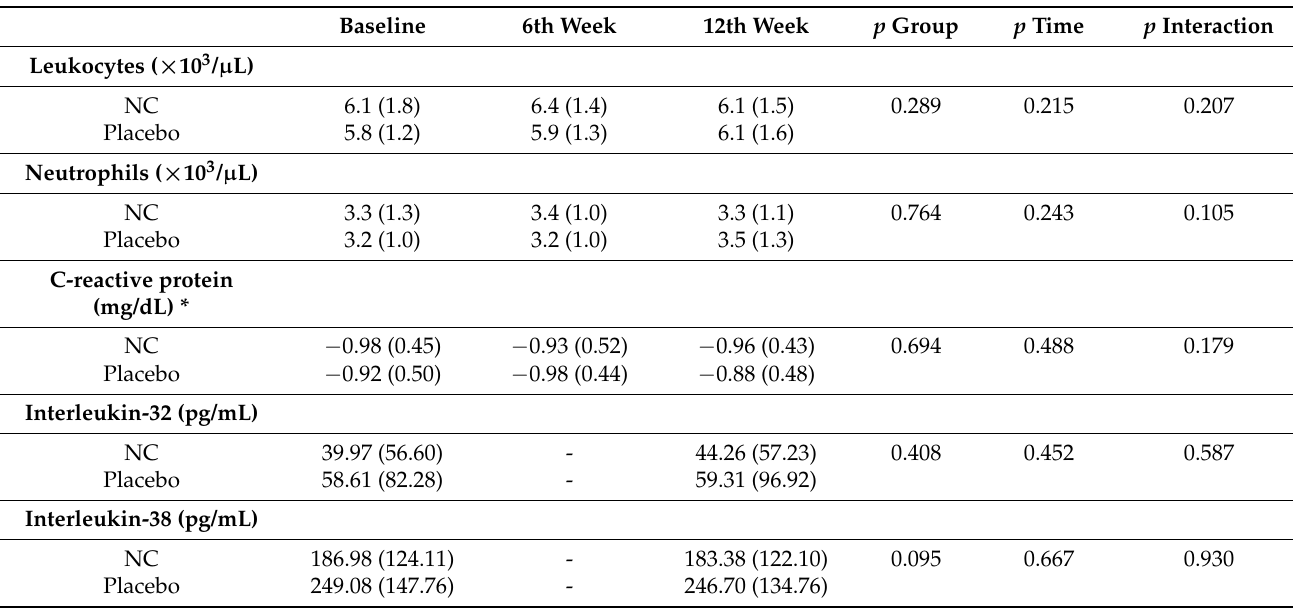
Table 4. Inflammatory parameters by group